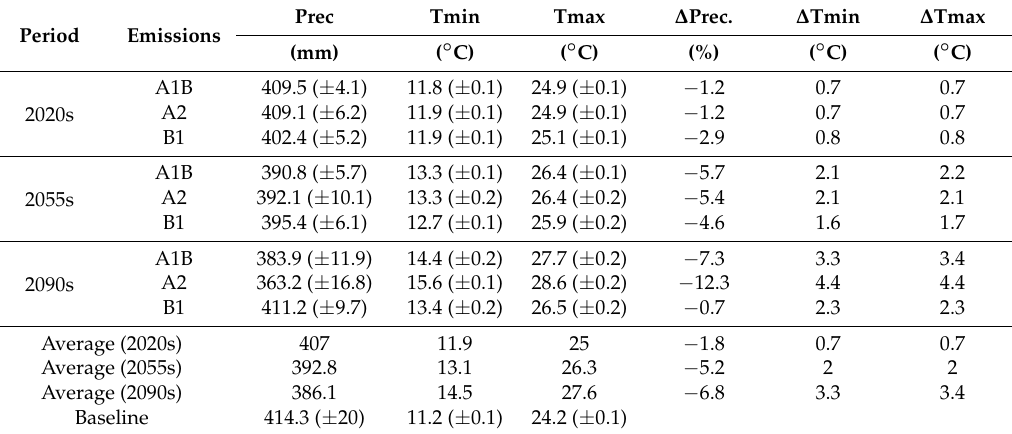
Table 3. Projected annual climate for the Brazos headwaters basin: annual prec. (mm), Tmin ( ◦ C), and Tmax ( ◦ C) averaged from 15 GCMs simulations across 55 grids. Values between parentheses represent the standard error of the mean (SE).